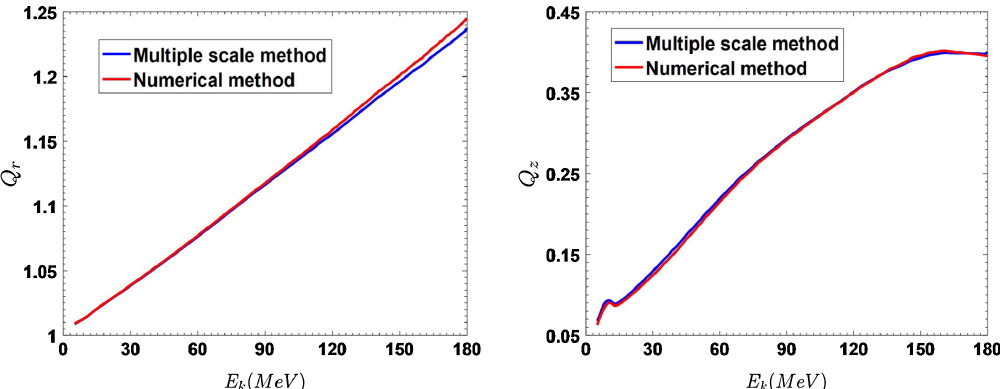
FIG. 4. Betatron tunes from the numerical method (red) and analytical solutions (blue): (left) radial oscillation and (right) vertical